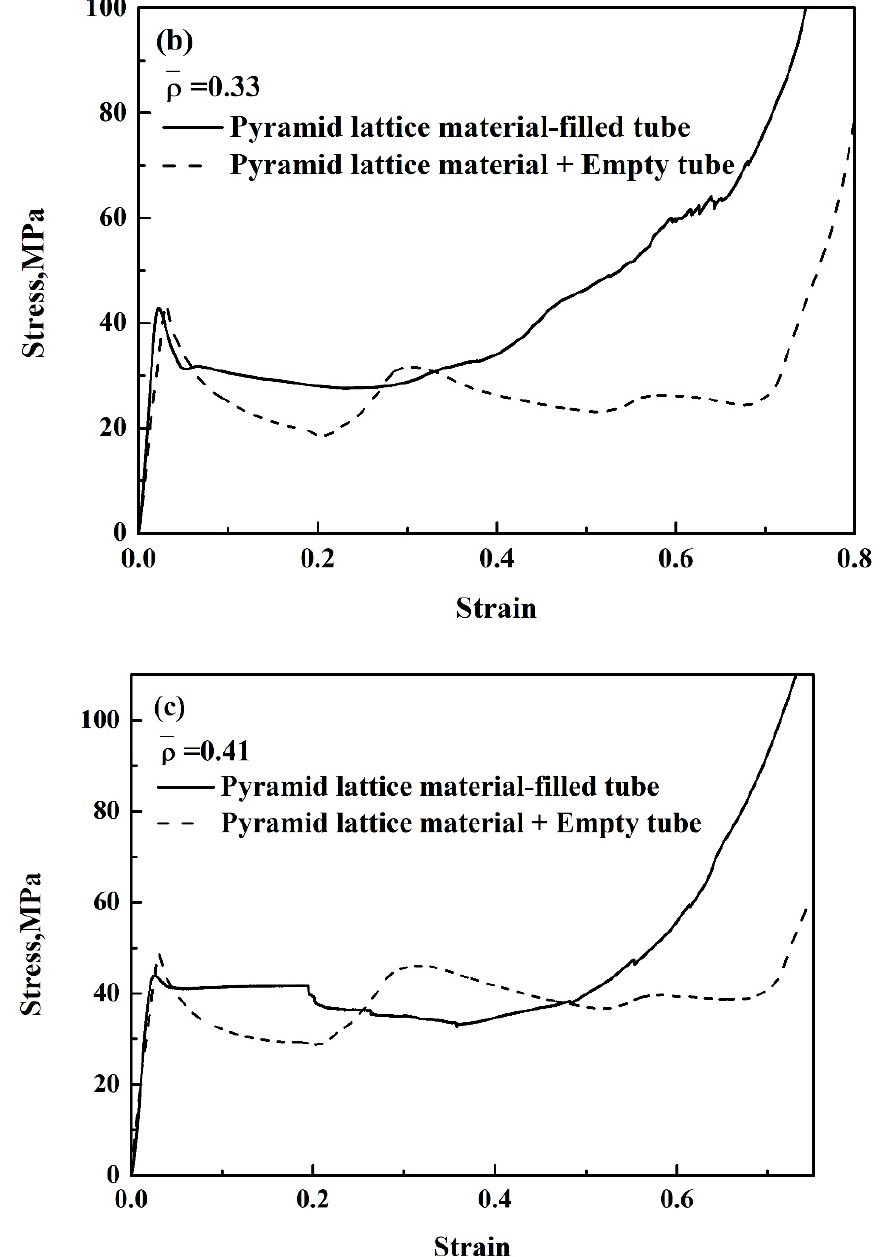
Figure 7. Stress–strain curves of the pyramid lattice material-filled tube and the pyramid lattice material + empty tube with lattice material of different relative densities: ( a ) 0.28, ( b ) 0.33, ( c ) 0.41.